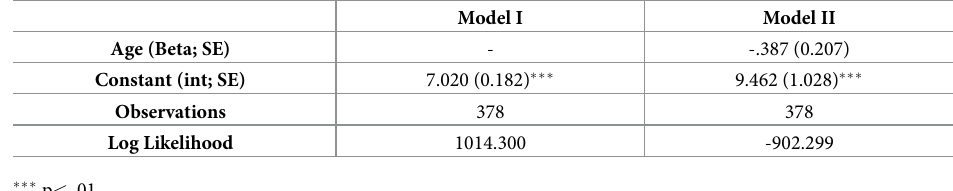
Table 7. Results of the regression models for determining hierarchy of